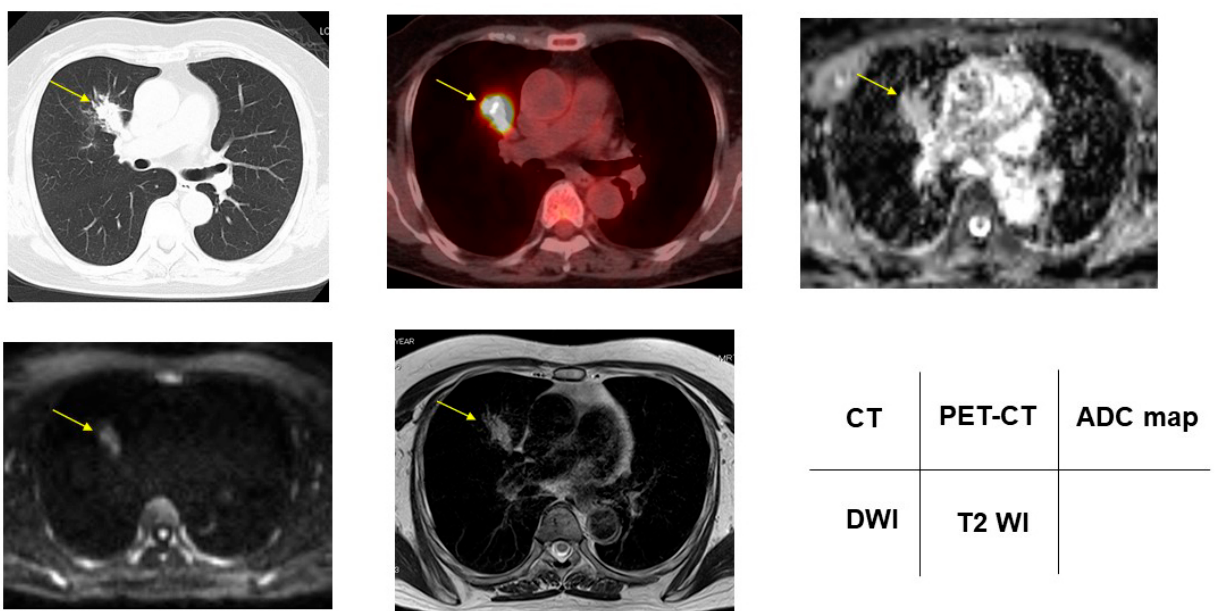
Figure 4. Nontuberculous mycobacteria showed 5.00 for SUVmax, DDS 3, 2.50 × 10 − 3 mm 2 /s for ADC, and 4.00 for T2 CR. Yellow arrows shows PNMs.